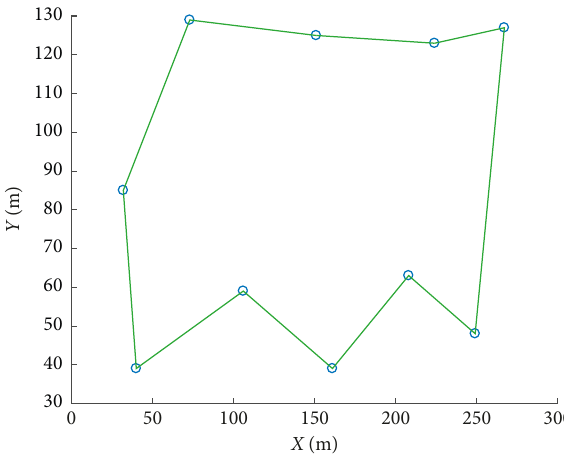
Figure 11: Optimal diagram of angular bisection path.